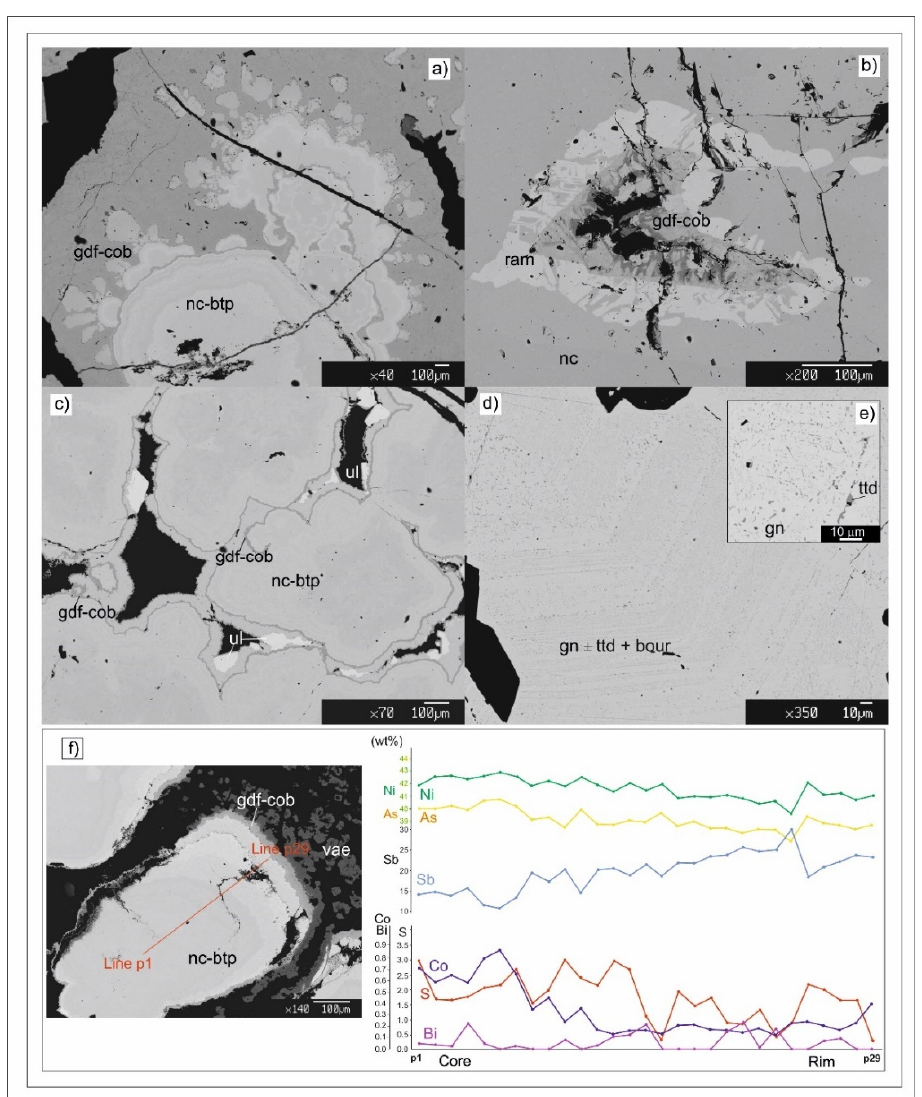
Figure 5. Selection of electron microscopy backscattered images from the SW Sardinian veins. ( a ) concretionary and zoned texture of niccolite nodules and their outer crusts made mostly of thin layers of gersdorffite–cobaltite—Acqua Is Prunas; ( b ) portion the arborescent niccolite concretions of Figure 4f with a cavity lined by rammelsbergite and then by gersdorffite–cobaltite—Pira Inferida; ( c ) zoned, Sb-bearing niccolite nodules with thin crusts of gersdorffite–cobaltite and with late growth of euhedral ullmannite—Acqua Is Prunas; ( d ) galena highly enriched in (sub-)micrometric inclusions of sulfosalts according to more or less regular patterns—Pira Inferida; ( e ) inset of ( d ) showing a portion of galena with relatively coarser sulfosalt inclusions amenable for EPMA analysis (tetrahedrite)—Pira Inferida; ( f ) SEM image of a niccolite–breithauptite nodule showing a progressive zoning (shades of grey-white) from core to rim, with an outer crust of gersdoffite–cobaltite and growth of secondary vaesite (vae) crystals (Acqua Is Prunas). The red line indicates the position of 29 data points for the analytical profiles for Ni, As, Sb, Co, and Bi shown in the nearby diagram. The Bi peaks may represent submicrometric native bismuth inclusions. Abbreviations: bour = bournonite, btp = breithauptite, cob = cobaltite, gdf = gersdorffite, gn = galena, nc = niccolite, ram = rammelsbergite, ttd = tetrahedrite, ul = ullmannite, vae = vaesite.